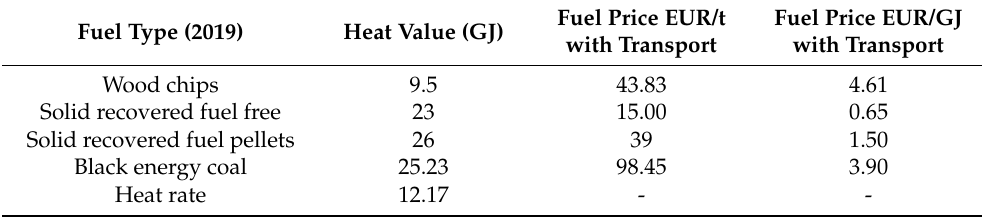
Table 1. Input data for cost calculation.